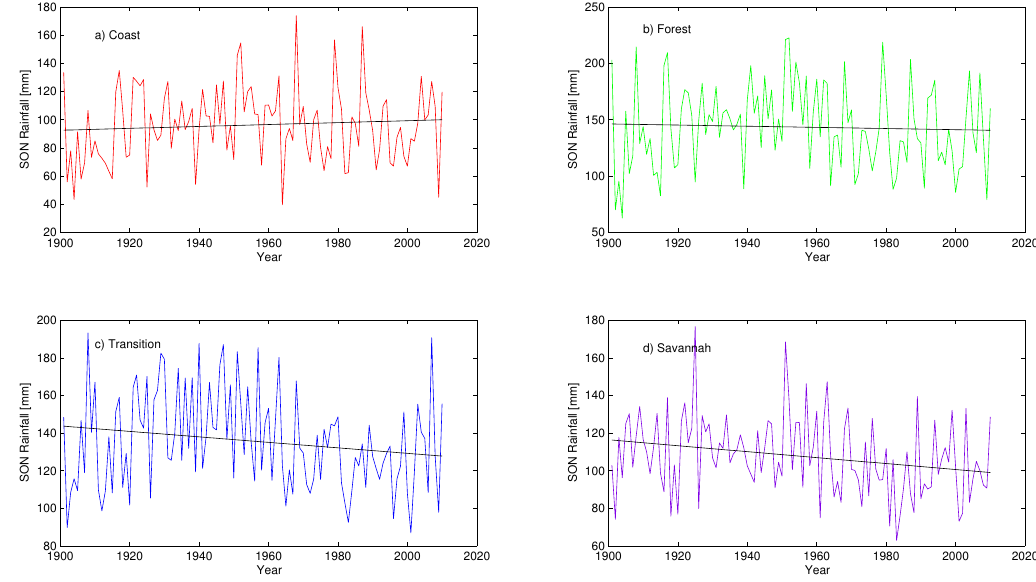
Figure 16. ( a – d ) Long-term course of seasonal rainfall over the agro-ecological zones of Ghana for